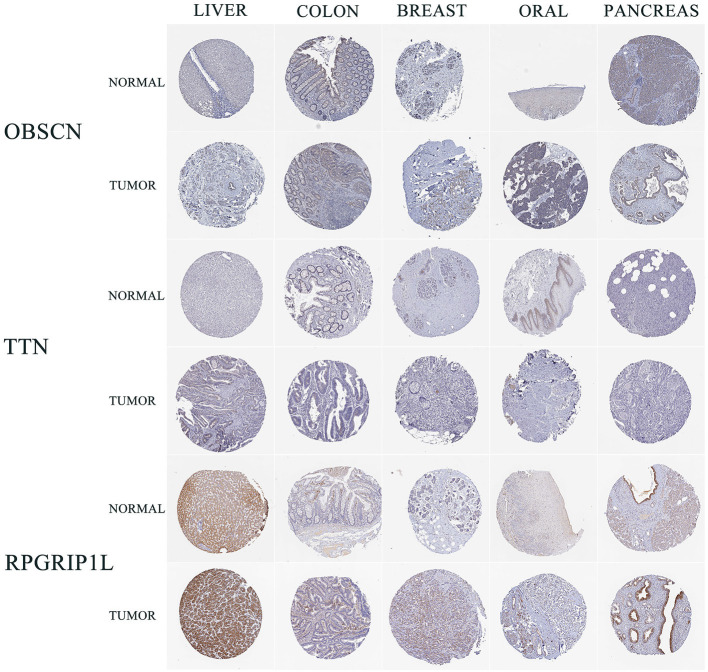
IHC results of three genes in five cancer types from HPA. IHC, immunohistochemistry; HPA, Human Protein Atlas; LIHC, liver hepatocellular carcinoma; COAD, colon adenocarcinoma; BRCA, breast invasive carcinoma; HNSC, head and neck squamous cell carcinoma; PAAD, pancreatic adenocarcinoma.